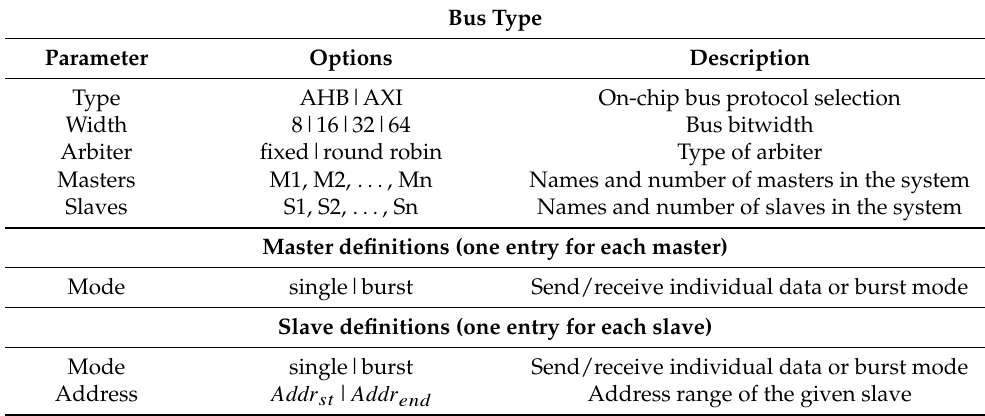
Table 2. Bus specification file